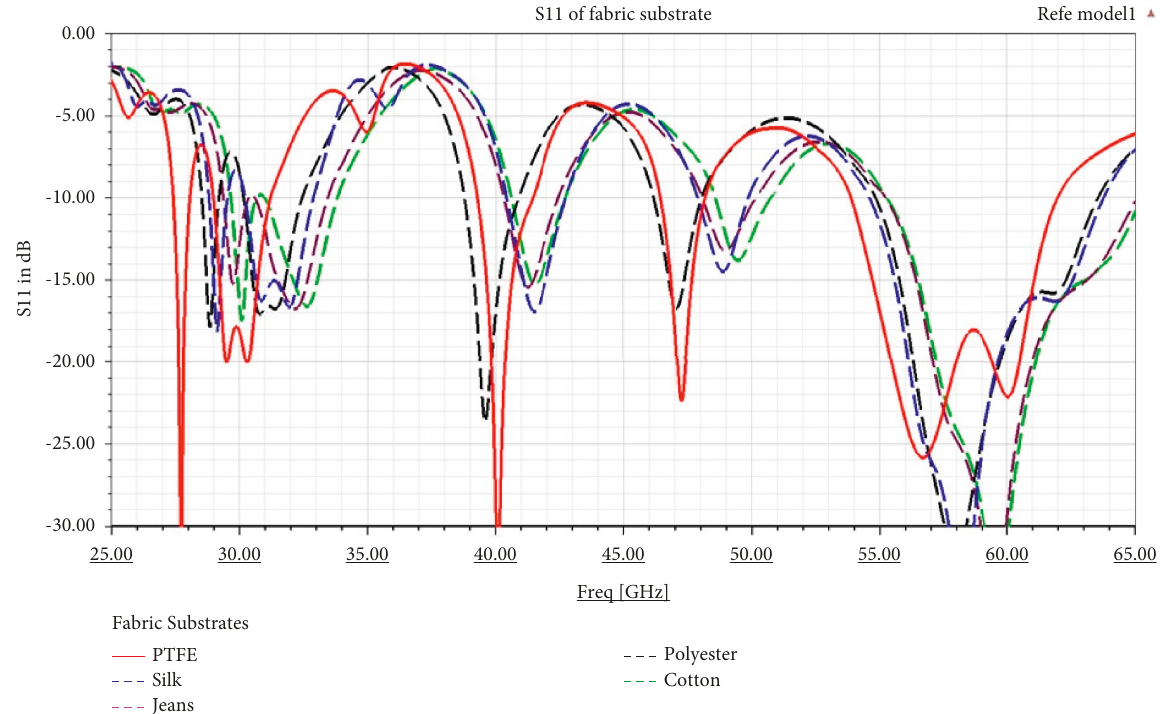
Figure 7: S result of the genetically optimized antenna with various fabric substrates. 11 Table 3: The performance of optimized antenna summary at various fabric